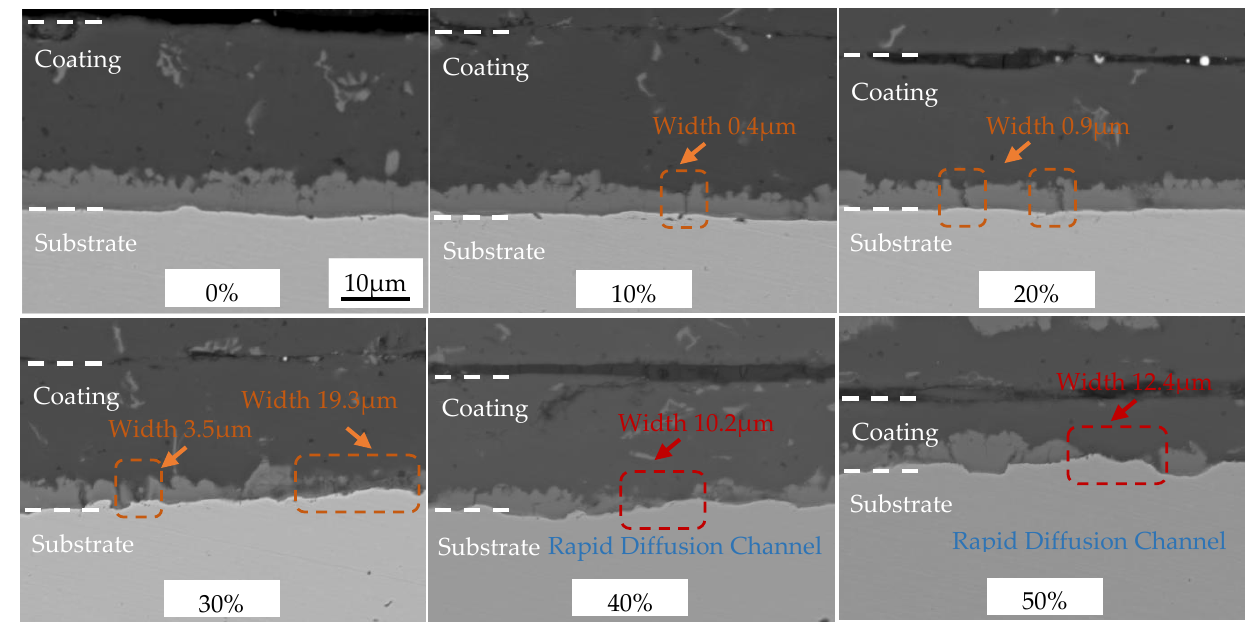
Figure 2. EPMA micrographs of AS60/60 coating at different reduction ratios.